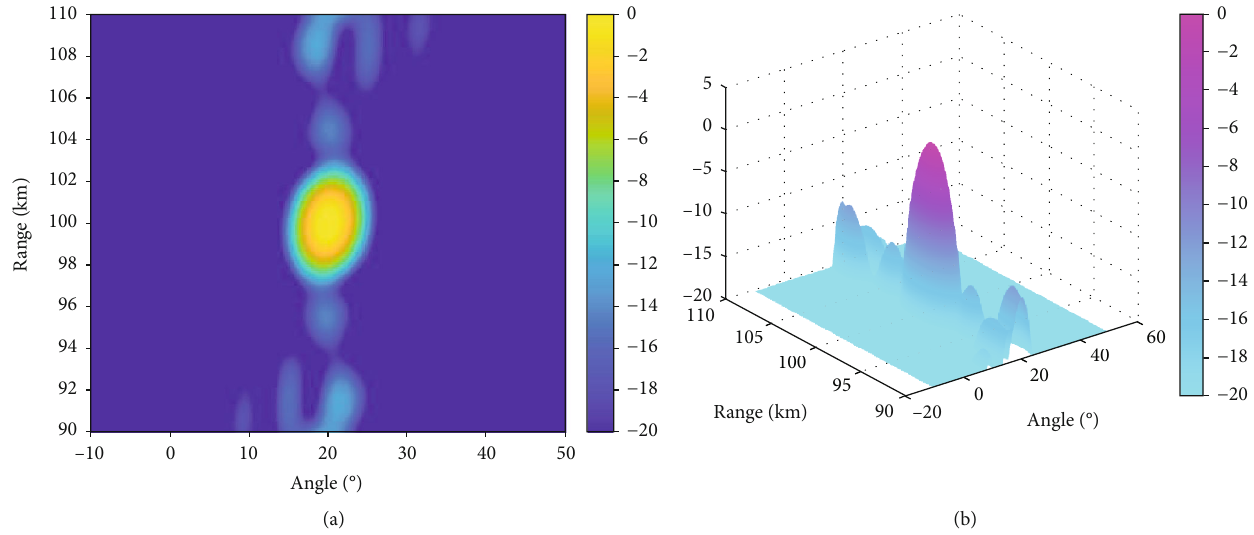
Figure 7: The equivalent transmit beampattern at the receiver: (a) the beampatterns of WAM_FDA (range-angle plane); (b) the beampatterns of WAM_FDA